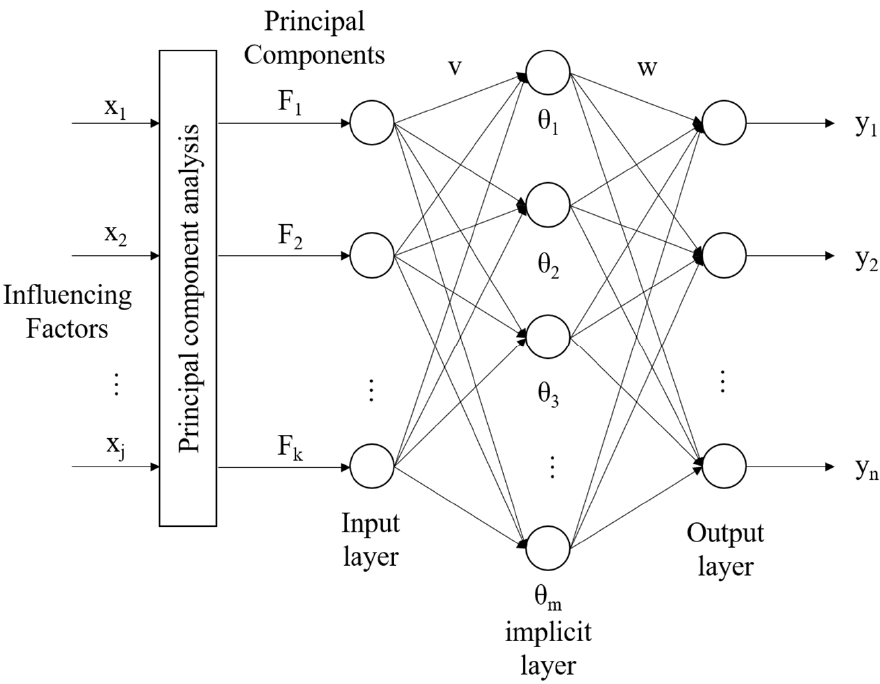
Figure 5. BP architecture diagram.